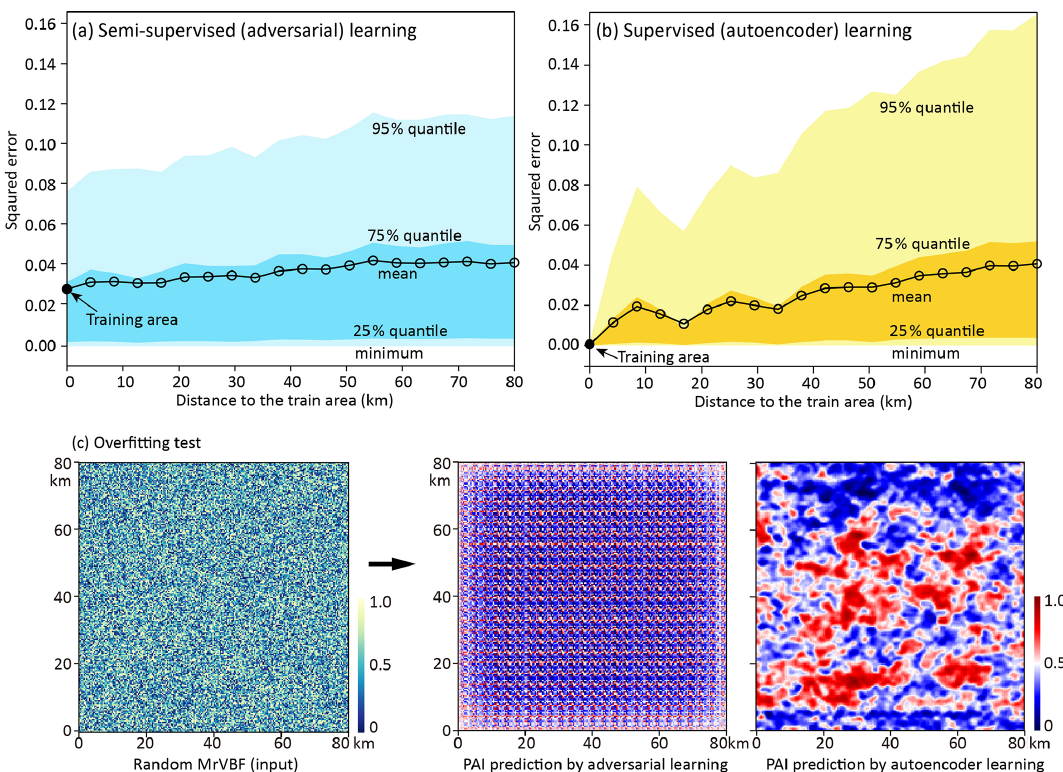
Figure 8. Squared errors between the true 3D paleovalley aquifer index (PAI) directly calculated from AEM-derived electrical conductiv- ity and PAI predicted by (a) an autoencoder neural network using supervised learning and (b) an adversarial neural network using semi- supervised learning in the areas west to the training area, with separation distance varying from 0 to 80km. (c) An overfitting test with a random 2D MrVBF as input to predict PAI at a depth of 30–40m following adversarial learning and only an